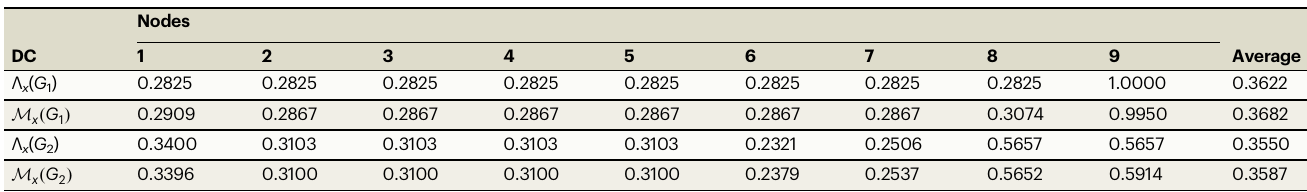
Table 1 | Mono and multilayer diffusion-capacity values for the system depicted in Fig. 4 Nodes